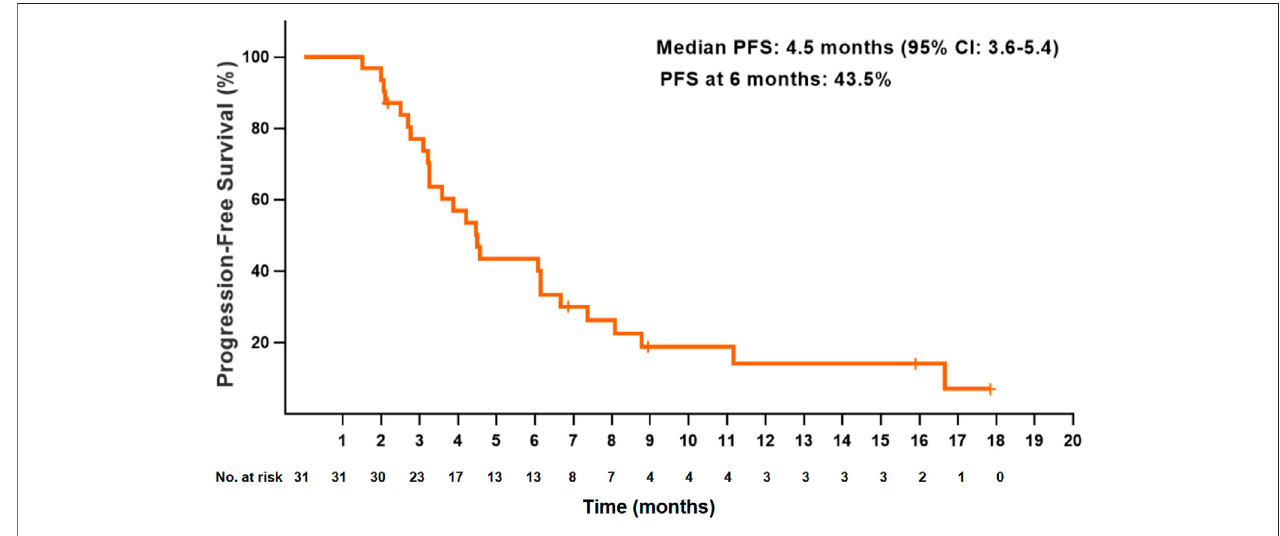
FIGURE 1 | Kaplan – Meier plot of progression-free survival in all patients.